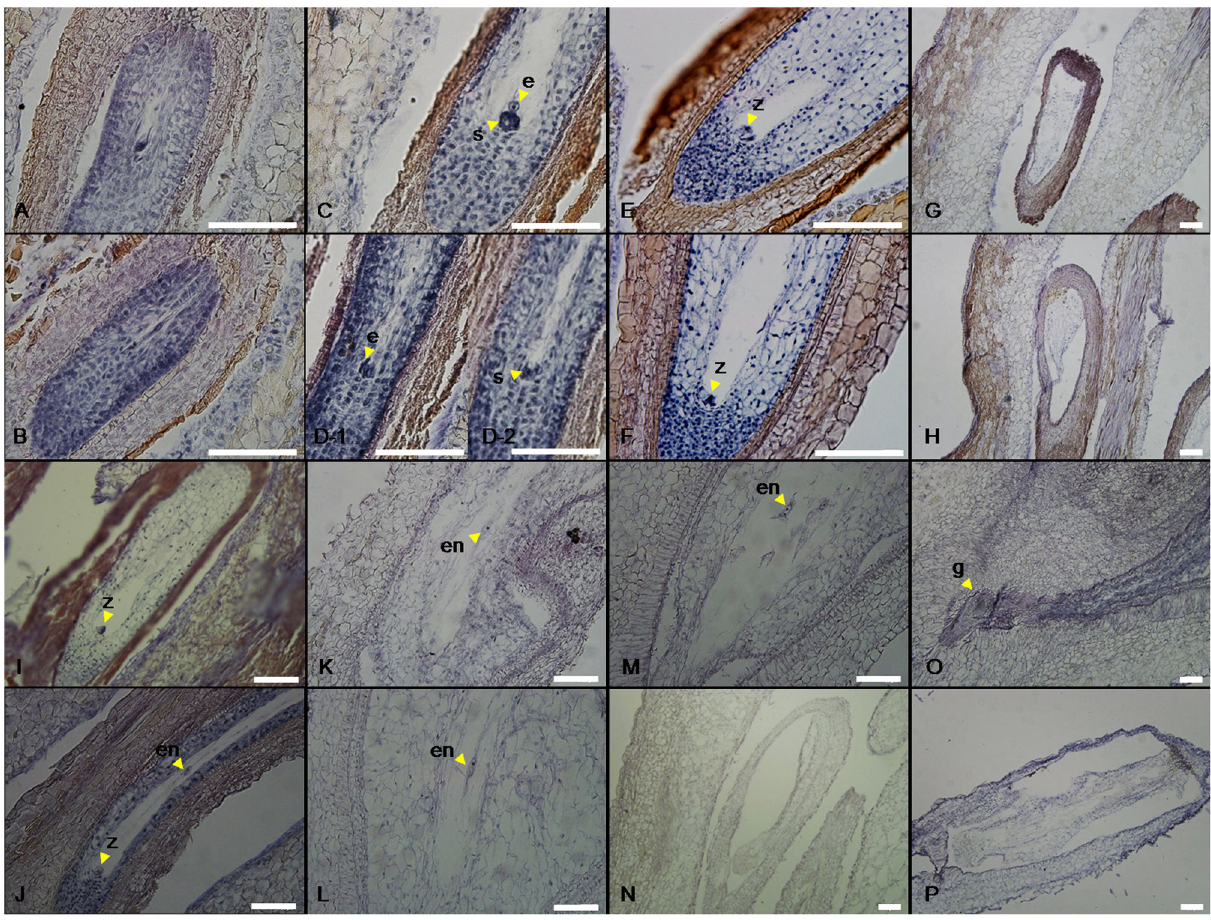
Figure 2. Seed development in untreated control and GA -treated ‘Kyoho’ grape. (A and B) Normal embryo sacs with 3 macrospore cells from untreated control (A) and treated (B) ovules 5 days after treatment; (C and D) egg cells and two synergids from untreated control (C) and treated (D) mature embryo sacs 9 days after treatment (D-1 and D-2 were contiguous sections); (E and F) zygotes from untreated control (E) and treated (F) seeds 17 days after treatment; (G and H) seeds with abnormal embryo sacs from treated grapes 17 days after treatment (G) and 21 days after treatment (3 DAF) (H); (I and J) normal zygotes from untreated control (I) and treated (J) seeds 21 days after treatment (3 DAF); (K and L) endosperm nuclei from untreated control (K) and treated (L) seeds 27 days after treatment (9 DAF); (M and N) embryo sac with endosperm nuclei from an untreated control seed (M) and abnormal embryo sac from a treated seed (N) 33 days after treatment (15 DAF); (O and P) early globular embryo from untreated control seed (O) and abnormal embryo sac from treated seed (P) 36 days after treatment (18 DAF). Scale bar = 100 μm, e: egg cell, en: endosperm nuclei, g: globular embryo, s: synergid, z: zygote.